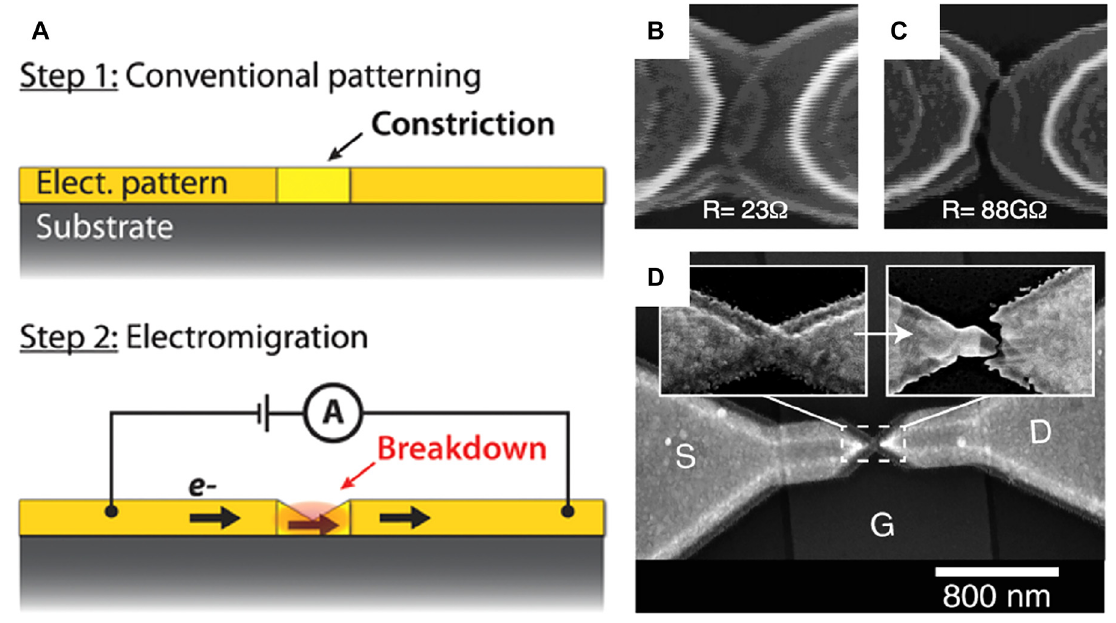
Figure 15: Fabricating nanometer-wide gaps with electromigration. (A) When electric current flows through a metallic pattern with a constriction, atoms diffuse gradually from the constriction, and eventually breakdown occurs to form a gap. (B) and (C) SEM images and resistance measured through the junction before and after electromigration process. (D) SEM image of a bowtie antenna fabricated with electromigration technique, operating at terahertz frequencies. Reproduced with permission from [160] (A) [161], (B) and (C) [29],